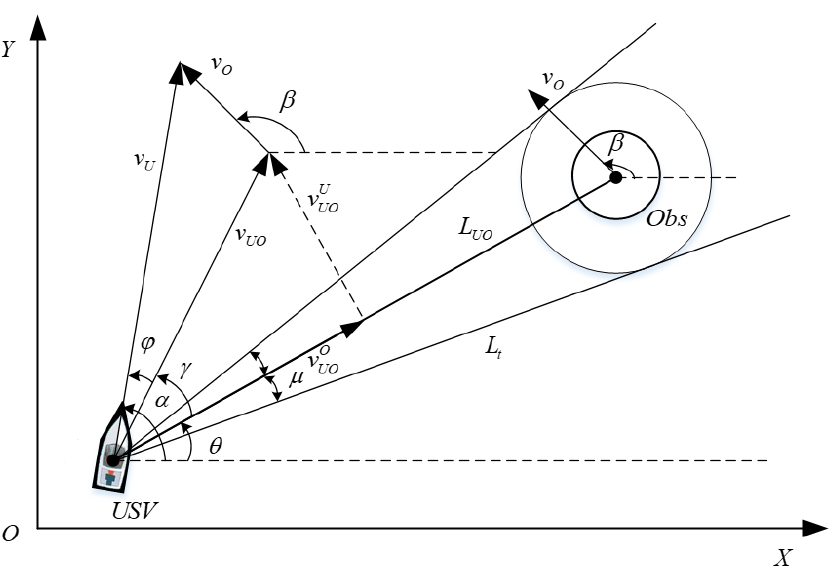
Figure 2. Circular collision avoidance